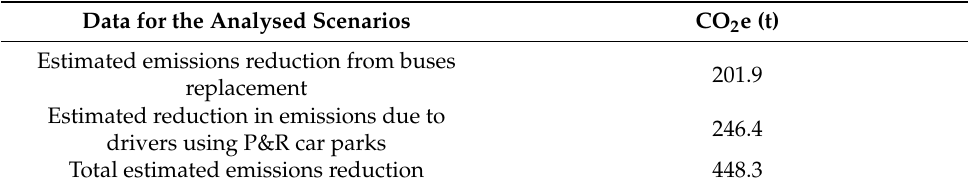
Table 8. Annual estimated decrease in greenhouse gas emissions CO 2 e for the analysed